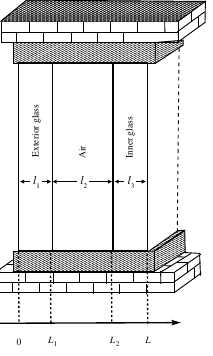
Figure 1. A schematic form of a a double-pane